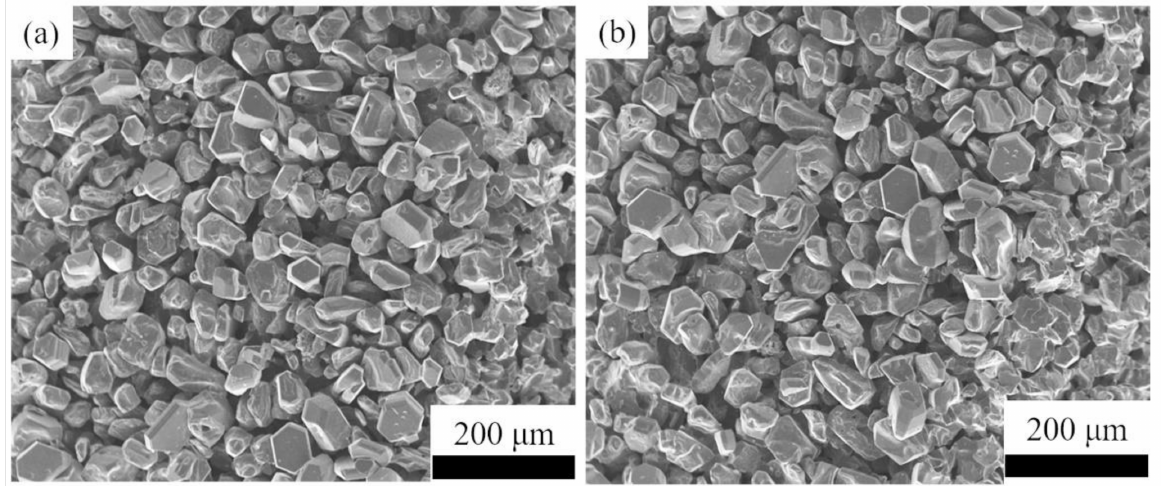
Figure 8. The morphology of SiC grains grown after two-step temperature control: ( a ) 2100 ◦ C for 10 min and 2300 ◦ C for 30 min; ( b ) 2150 ◦ C for 10 min and 2300 ◦ C for 30